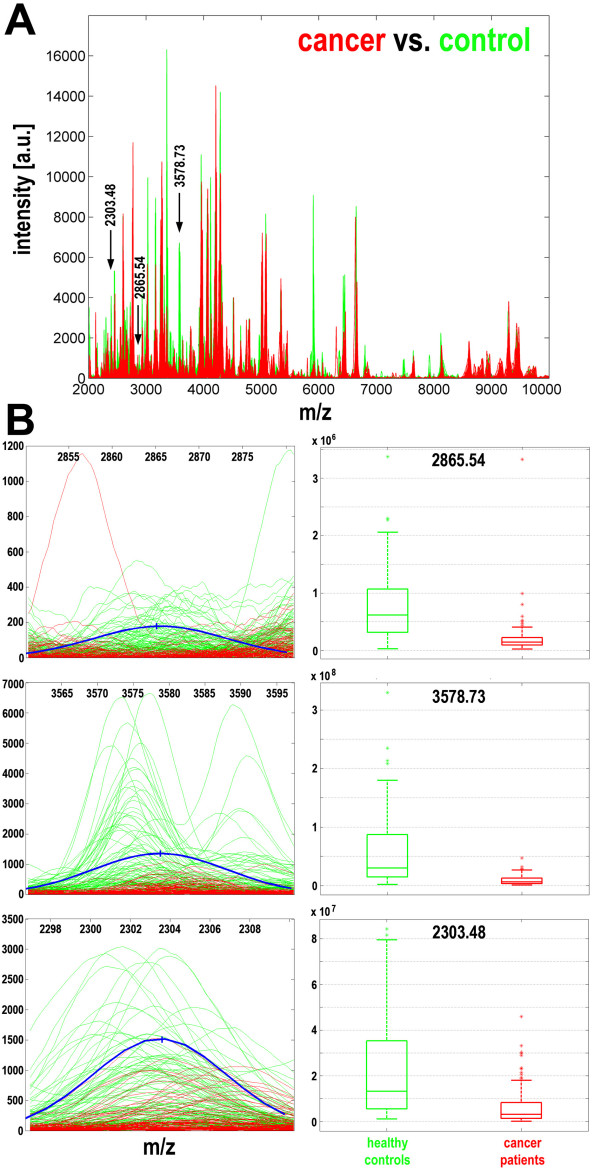
Characterization of spectral components essential for cancer classification. A – The three most frequent differentiating components are marked with arrows along the mass spectra of serum samples of cancer patients (red lines) and healthy controls (green lines). B – Actual spectral plots of three selected components for cancer patients (red lines) and healthy controls (green lines), as well as modeled Gaussian kernels (blue curves); X-axes represent the m/z values, Y-axes represent intensities. Box-plots on the right represent quantification of the abundance of spectral components in samples from cancer patients (red) and healthy controls (green) (shown are minimum, lower quartile, median, upper quartile and maximum values; outliers are marked by asterisks).